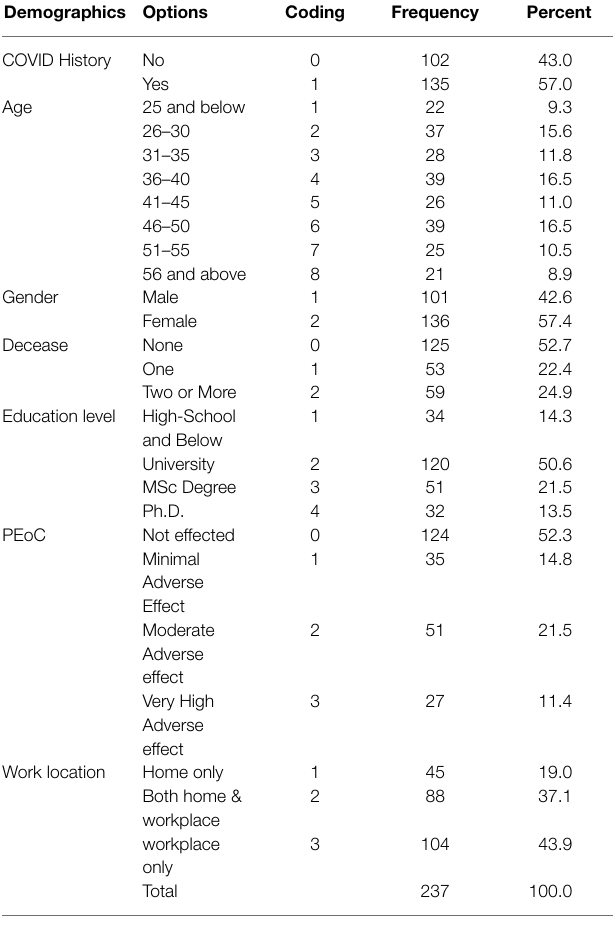
TABLE 1 | Demographics of the participants. Demographics